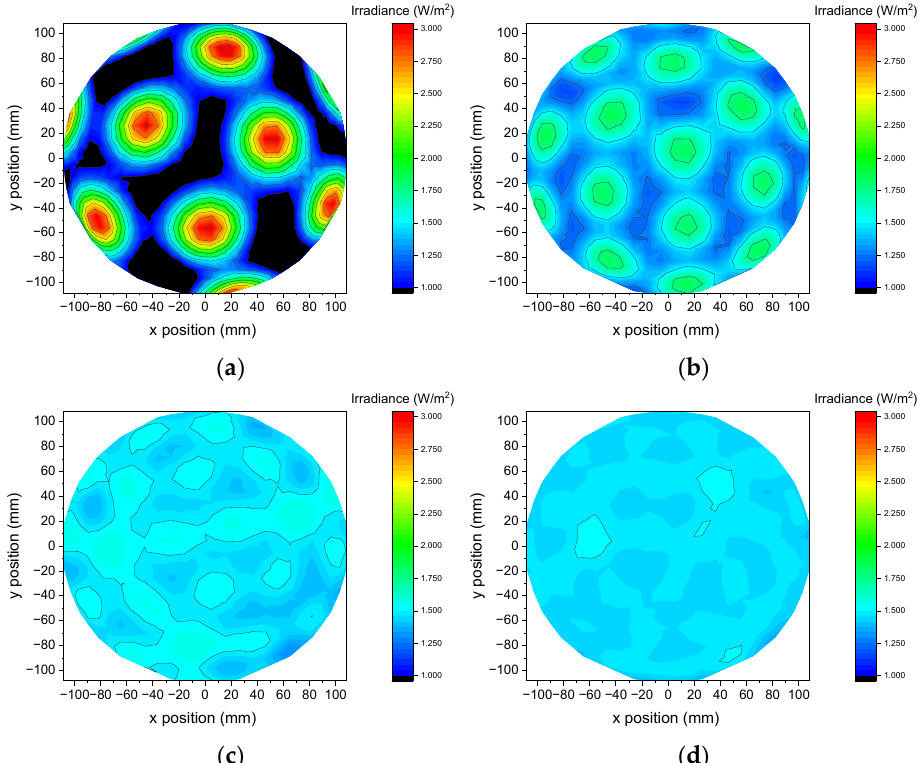
Figure 6. Optical simulation results: irradiance on the surface of the sphere, total optical power is constant at 500 mW, ( a ) 25 points, ( b ) 50 points, ( c ) 75 points, ( d ) 100 points.